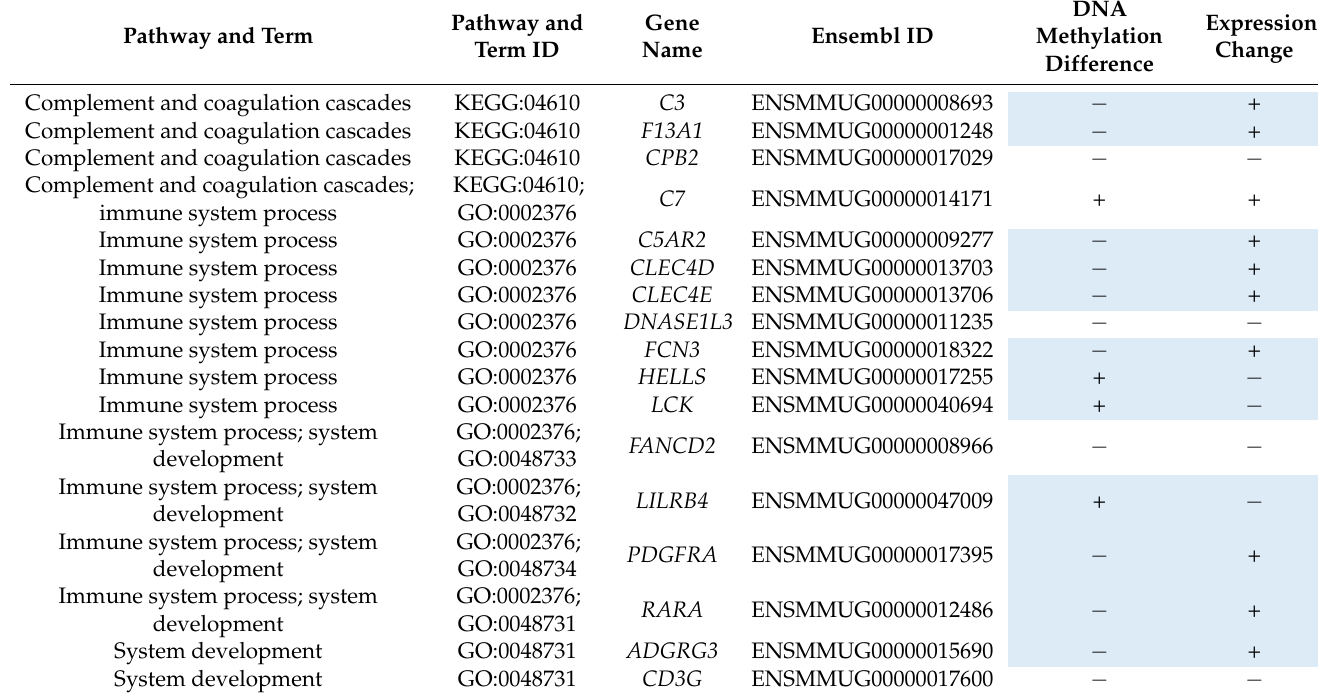
Table 1. Alterations of the methylation level and expression level in the 45 overlapping genes of DMGs and DEGs related to